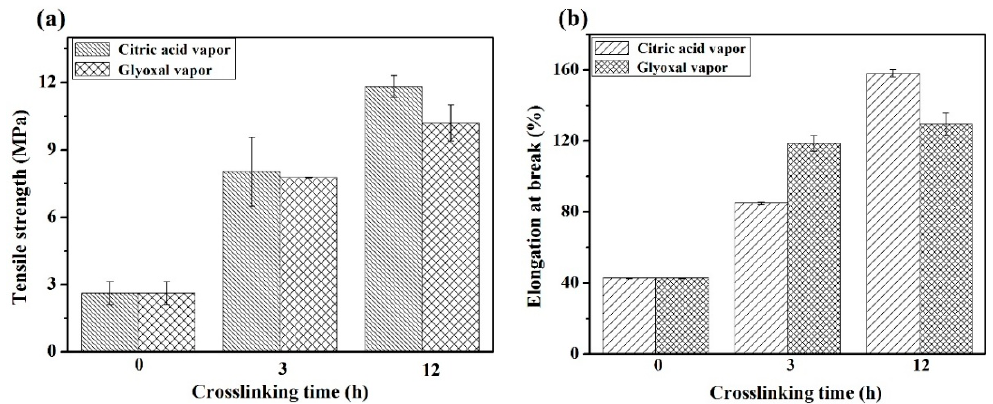
Figure 7. The mechanical properties of as-prepared and crosslinked FK/PVA/PEO nanofiber membranes: ( a ) tensile strength ( σ b ); and ( b ) elongation at breakage point ( ε b ).